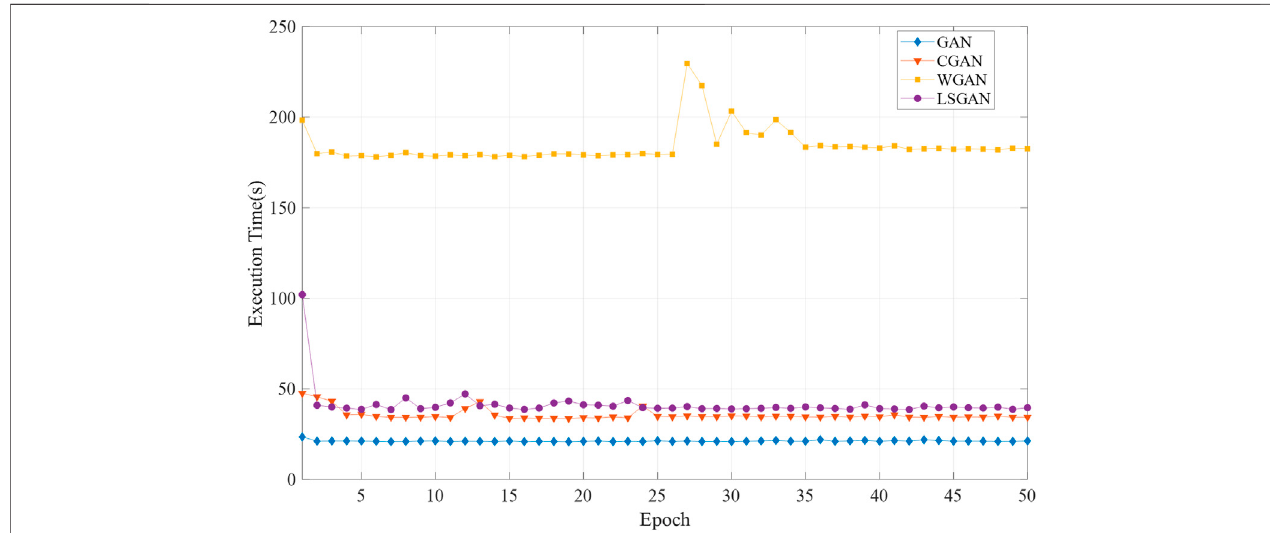
FIGURE 7 | Computational time consumption curves for each training cycle of different methods.